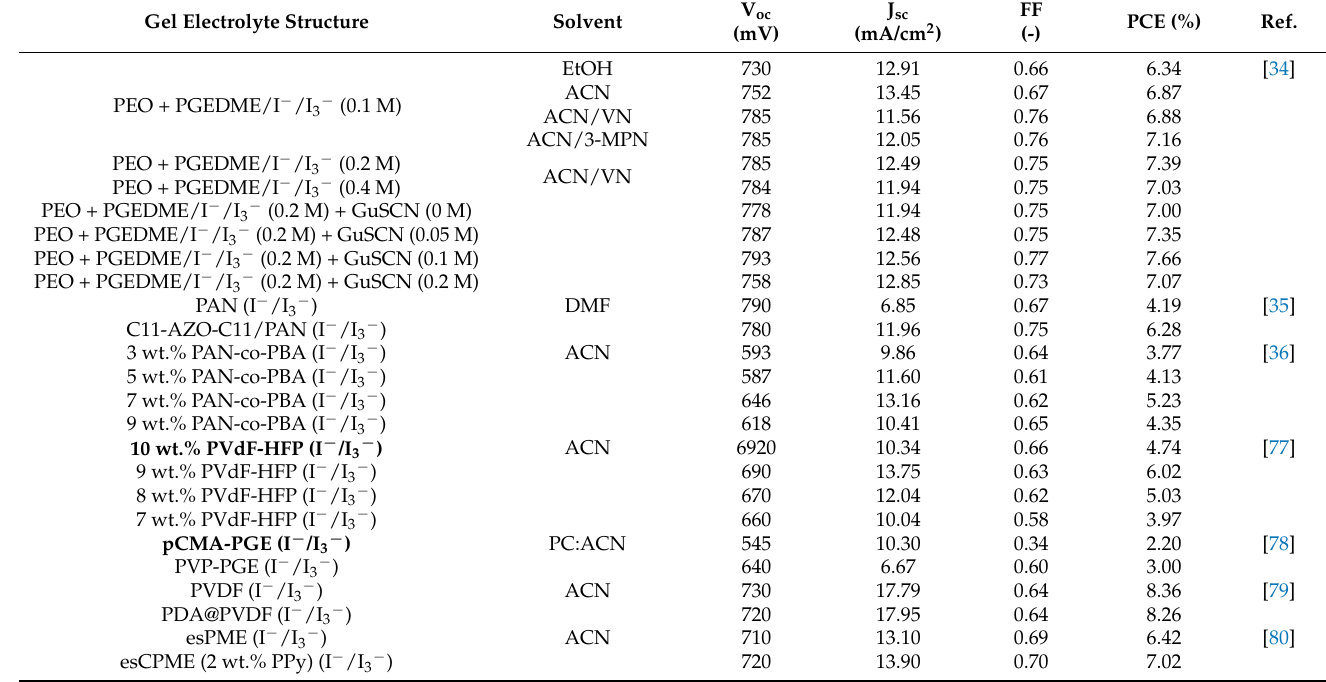
V oc J sc FF PCE (%) Ref. (mV) (mA/cm 2 ) (-)